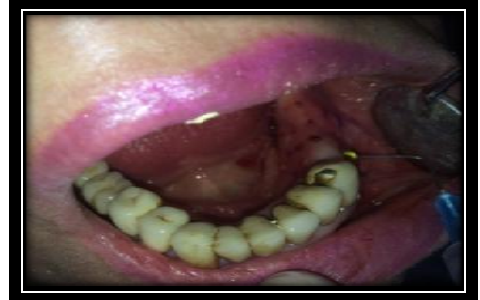
Fig. 2: Measurement of thickness of mucosa